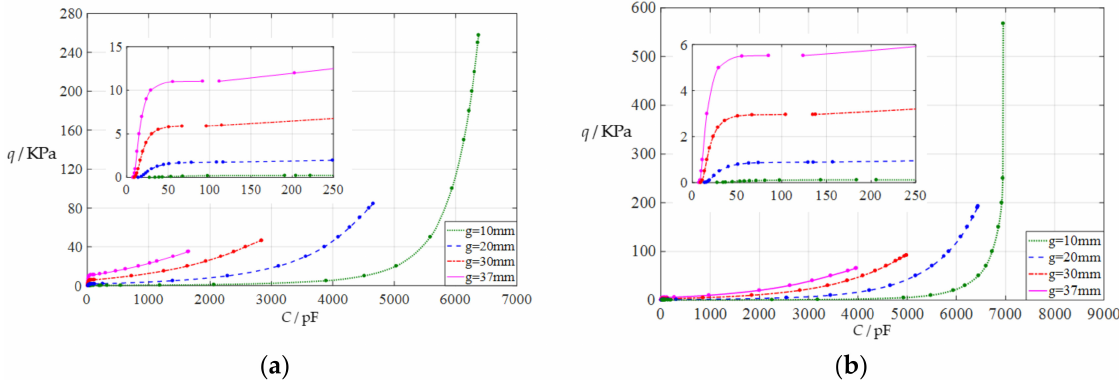
Figure 6. The capacitance–pressure relationships of a circular capacitive pressure sensor from non-touch mode of operation to touch mode of operation: ( a ) for a = 100 mm, h = 1 mm, t = 0.1 mm, E = 5 MPa, ν = 0.47, and g = 10 mm, 20 mm, 30 mm, and 37 mm; ( b ) for a = 100 mm, h = 1 mm, t = 0.1 mm, E = 2.5 MPa, ν = 0.47, and g = 10 mm, 20 mm, 30 mm, and 37 mm.